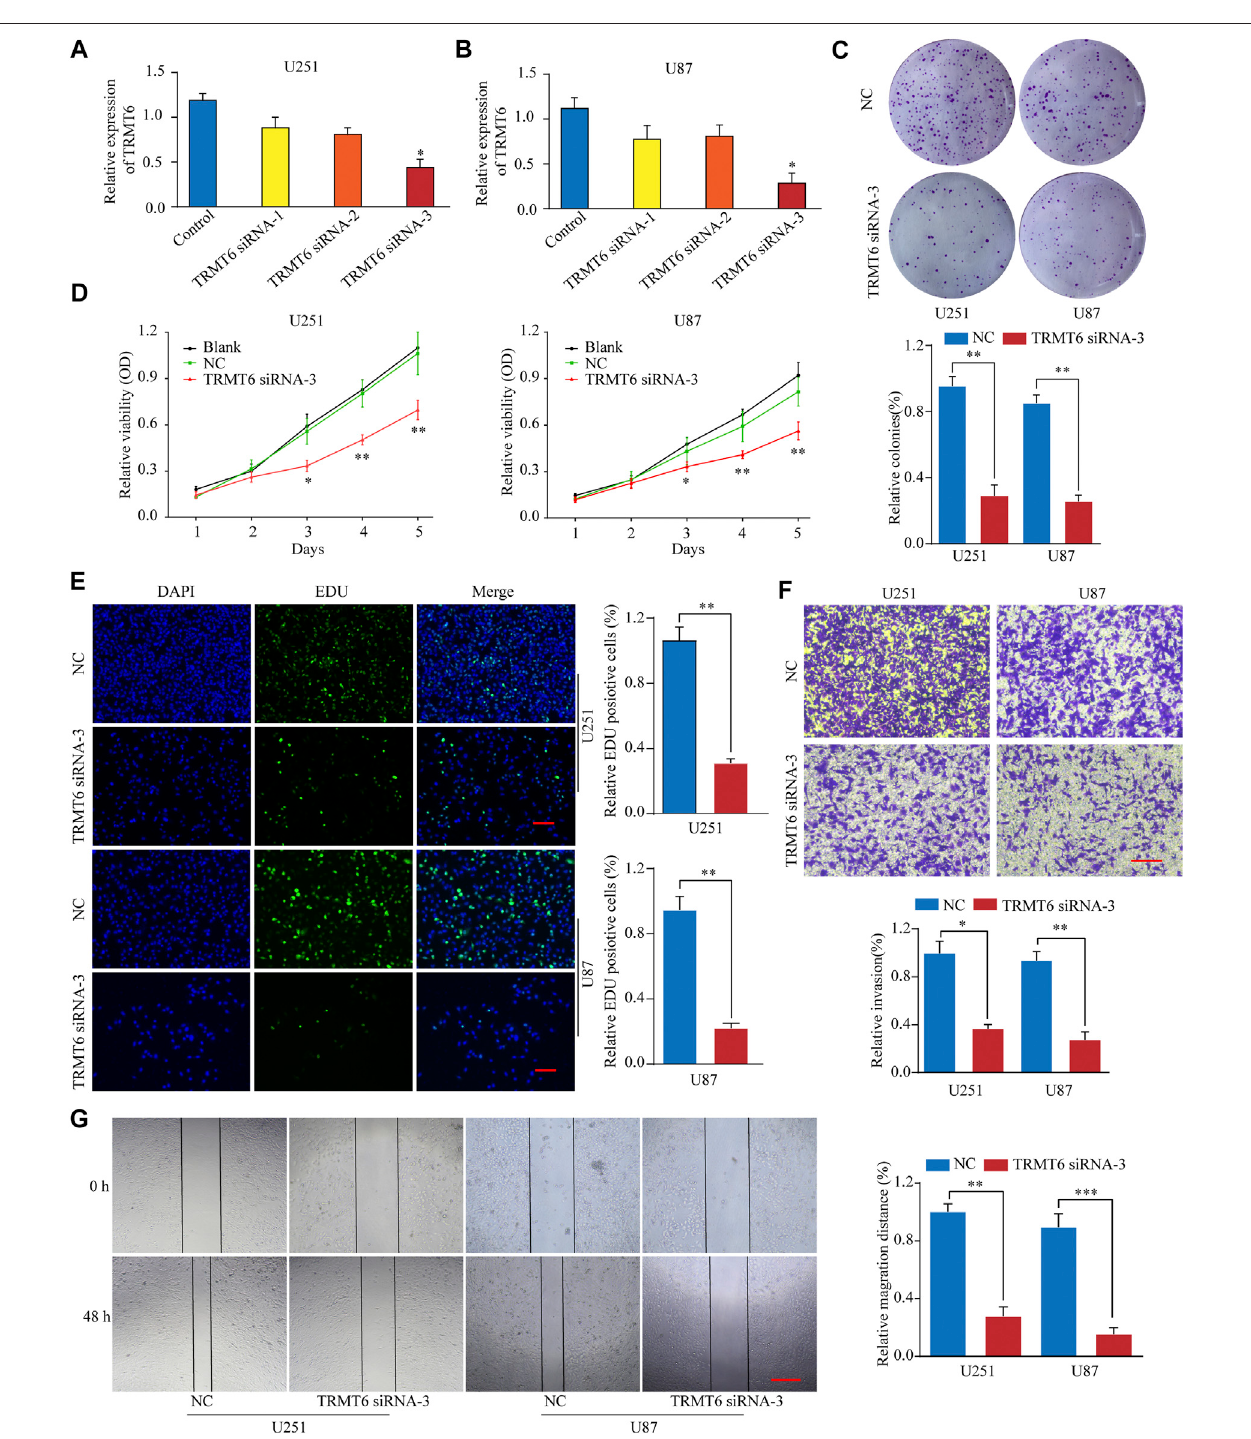
FIGURE 5 | TRMT6 silencing inhibits glioma cell proliferation, migration, and invasion. (A, B) : qRT-PCR analysis of TRMT6 expression in glioma cells after transfection with control or TRMT6 siRNAs. (C) : Knockdown of TRMT6 dramatically inhibited the cell colony formation ability. (D) : Cell proliferation of U251 or U87 cells transfected with NC or TRMT6 siRNA was analyzed by CCK-8 assay. (E) : Cell proliferation of U251 or U87 cells transfected with NC or TRMT6 siRNA was analyzed by EdU staining assay. Scale bar, 50 μ m. (F) : Decreased TRMT6 inhibited U251 or U87 cell invasion ability. Scale bar, 50 μ m. (G) : Decreased TRMT6 inhibited U251 or U87 cell migration ability. Scale bar, 50 μ m * p < 0.05, ** p < 0.01, *** p < 0.001.